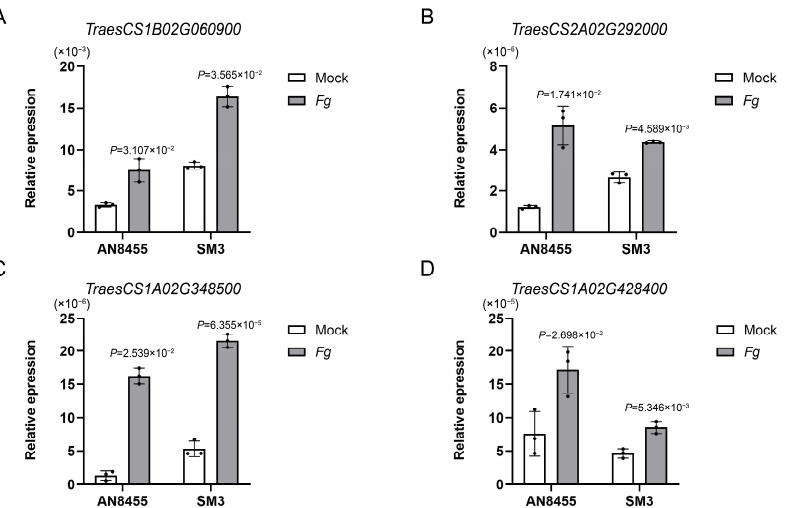
Figure 7. Upregulation of genes involved in the metabolic pathways after F. graminearum infection. ( A ) Histogram of adenosylhomocysteine nucleosidase gene expression in AN8455 and SM3. The wheat tubulin gene was used as the internal control, and a t -test was used to compare significant differences. ( B ) Histogram of arogenate dehydratase gene expression in AN8455 and SM3. ( C ) Histogram of malate dehydrogenase gene expression in AN8455 and SM3. ( D ) Histogram of tryptophan synthase alpha chain gene expression in AN8455 and SM3. Error bars show the standard deviation. Data are presented as mean ± SD (n = 3).